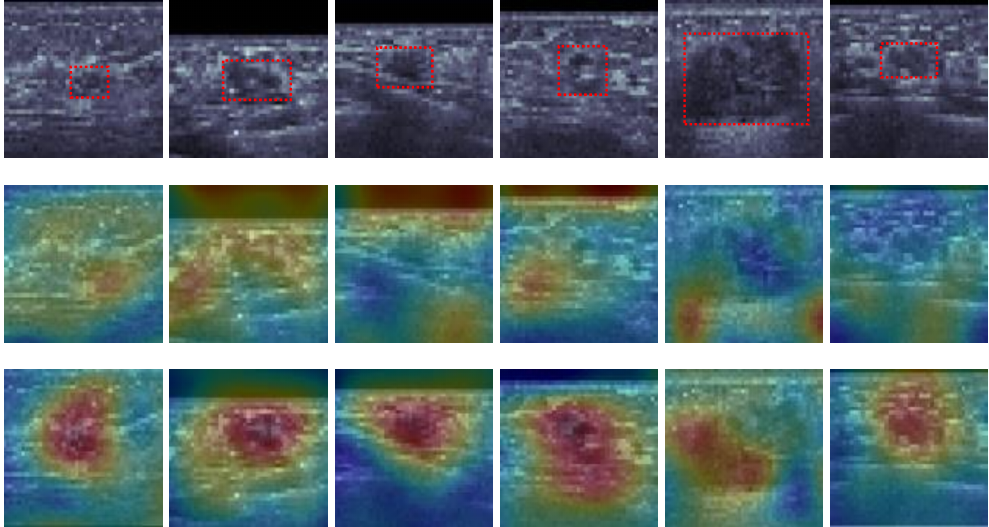
Figure 7. Class activation maps (CAMs) to show the effect of the mask branch network (MBN). ( Top row ) Breast mass samples on ABUS images marked by red boxes. ( Middle row ) CAMs of DenseNet. ( Bottom row ) CAMs of DenseNet with